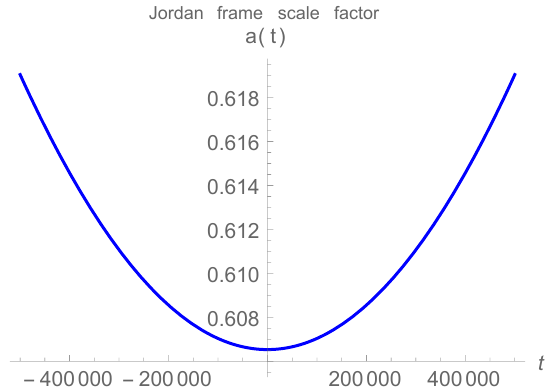
Figure 3. Time evolution of the scale factor in the Jordan frame for a bounce in vacuum background in exponential gravity found with the initial conditions φ ( 0 ) =